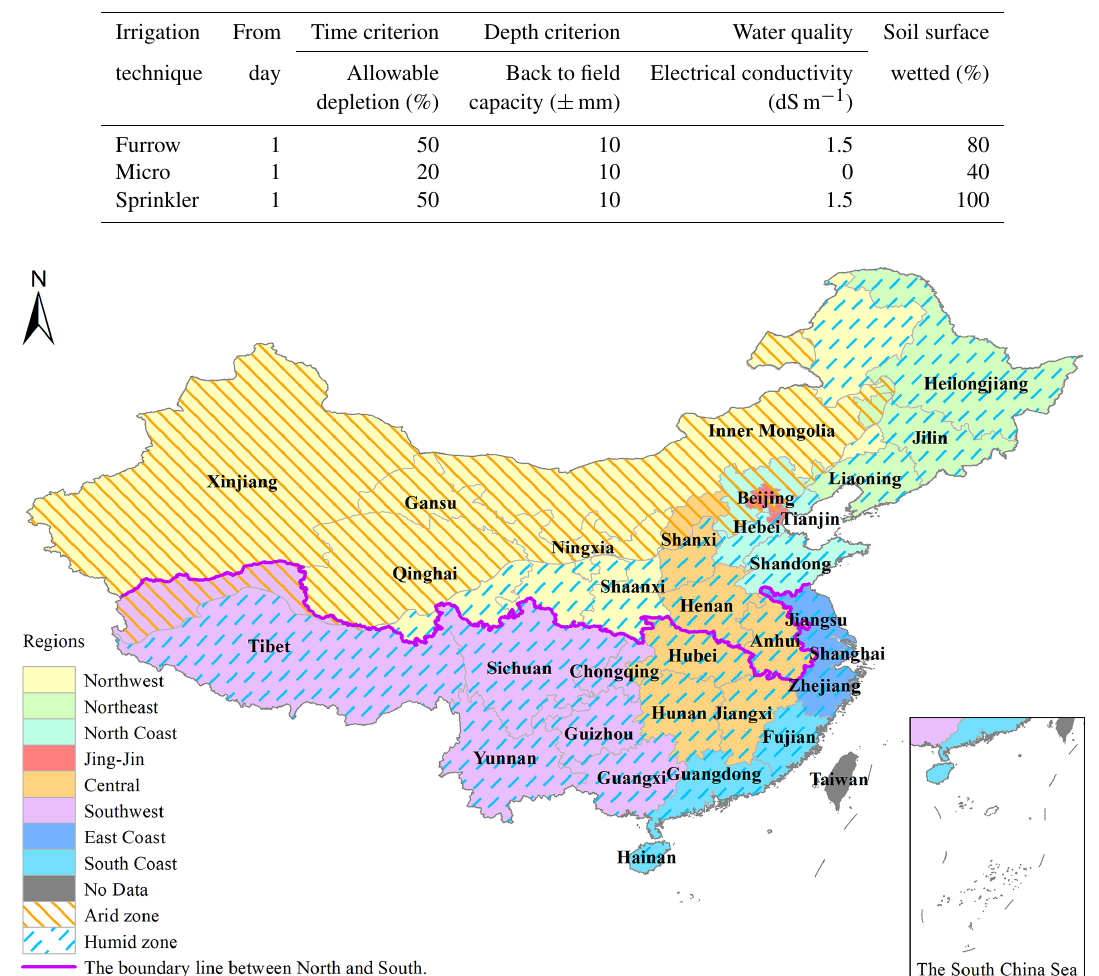
Table 2. Parameters of three irrigation techniques.